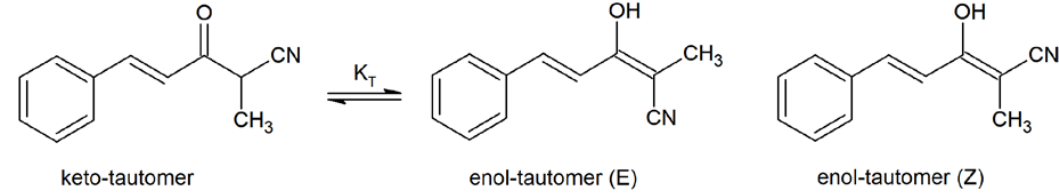
Figure 4. MDS plot of all solvents present in the dataset. Dimension 1 (D1) on x-axis and dimension 2 (D2) on y-axis. Small subsets of aromatic solvents, alcohols, dipolar aprotic solvents, and alkanes are highlighted.